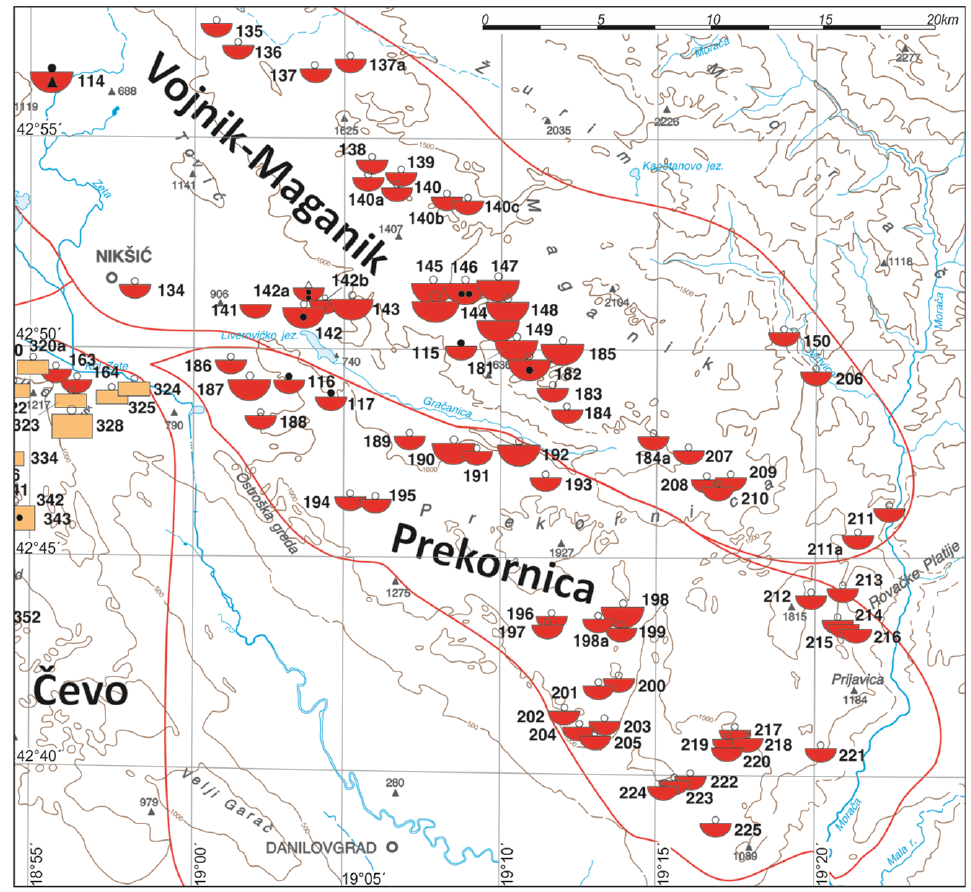
Figure 3. Deposits and occurrences of karstic bauxites of Vojnik-Maganik and Prekornica bauxite- bearing regions (after Pajovi ć [15], modified).